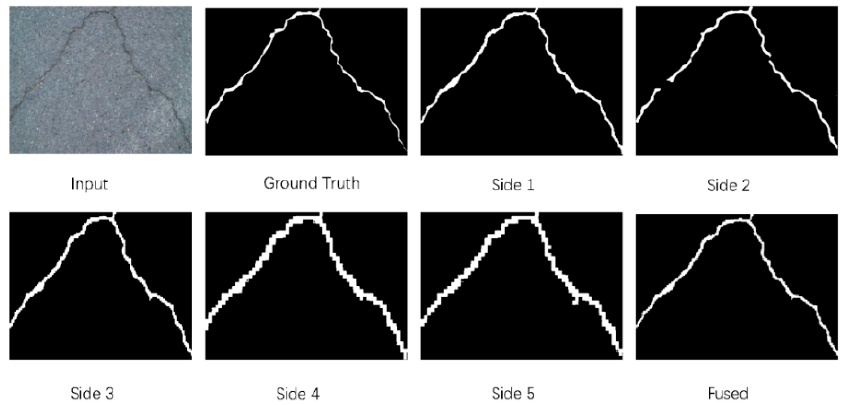
Figure 6. A real example of crack detection based on U-HDN. It shows the comparison between ground truth for input image and fused feature maps at different scales.